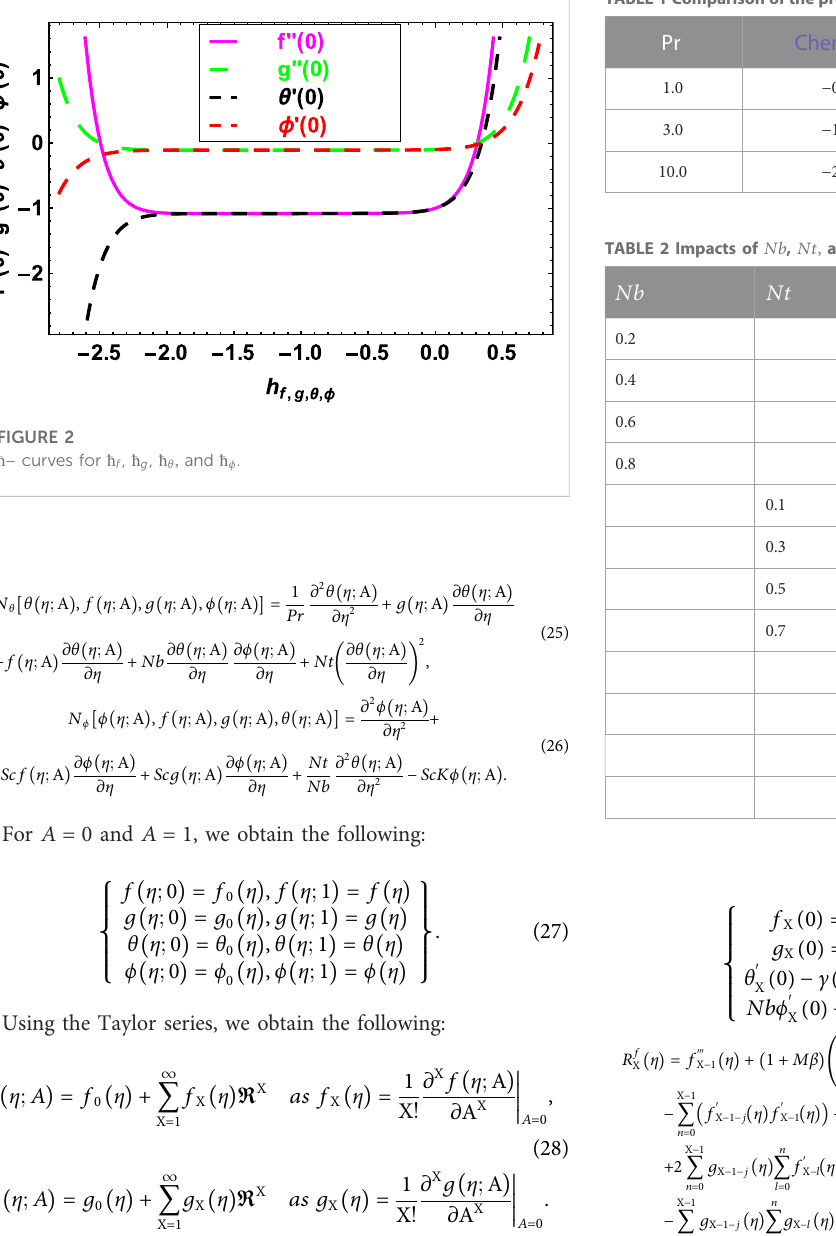
TABLE 1 Comparison of the present results of − θ ( 0 ) with the published results.